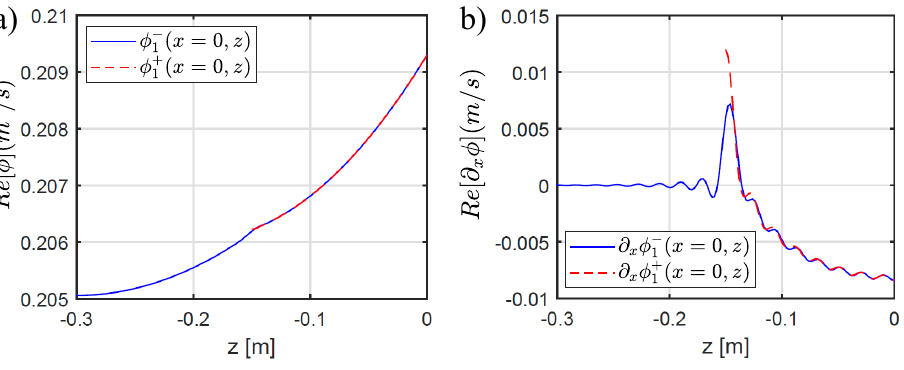
Figure 3. ( a ) Vertical profile at x = 0 of the velocity potential at the first-order φ 1 . ( b ) Vertical profile at x = 0 of the horizontal velocity at the first-order ∂ x φ 1 .